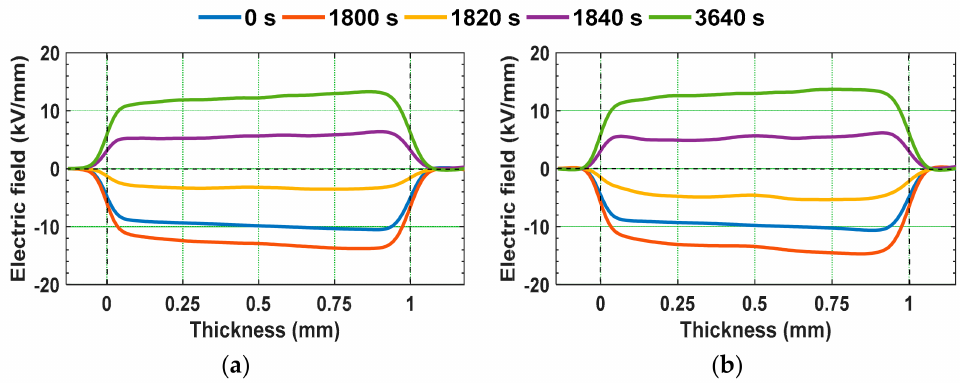
Figure 11. Electric field distribution under polarity reversal from positive to negative DC field stress in ( a ) virgin and ( b ) 8 kGy gamma irradiated specimens [29].